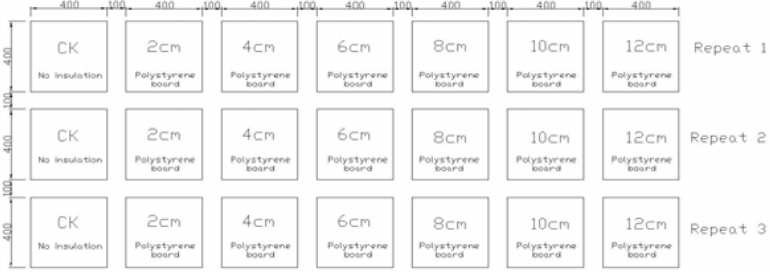
Figure 1. Planar layout of different treatment blocks.